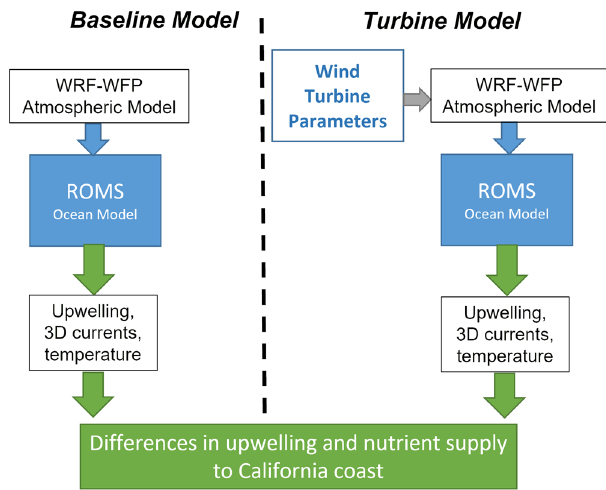
Fig. 10 Flowchart of atmosphere – ocean numerical modeling